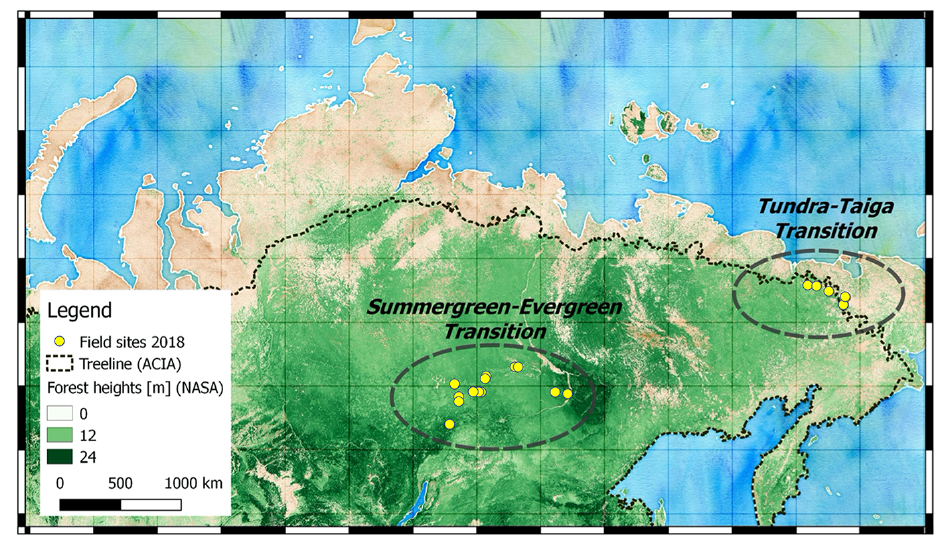
Figure 1. Overview of the Siberian transition zones: the tundra–taiga transition in Chukotka and the summergreen–evergreen transition in central Yakutia that were covered by the 2018 Chukotka expedition (yellow points represent 2018 field sites with vegetation plots). The overview map (background © OpenStreetMap contributors 2022. Distributed under the Open Data Commons Open Database License (ODbL) v1.0) shows forest coverage by green color-coded NASA forest height (Simard et al., 2011) and the northern treeline (CAVM Team 2003, for Arctic Climate Impact Assessment, ACIA).